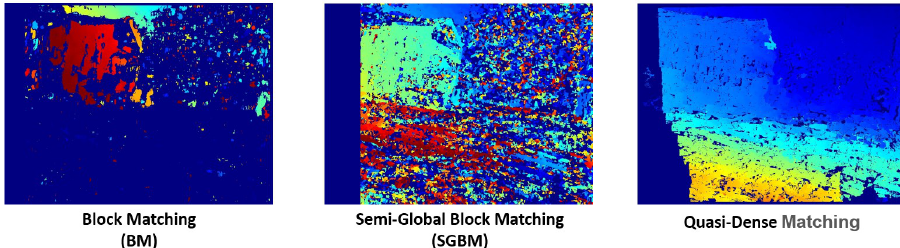
Figure 8. Comparison of Block Matching (BM), Semi-Global Block Matching (SGBM), and Quasi- Dense matching algorithm in a sample non-perfectly rectified image